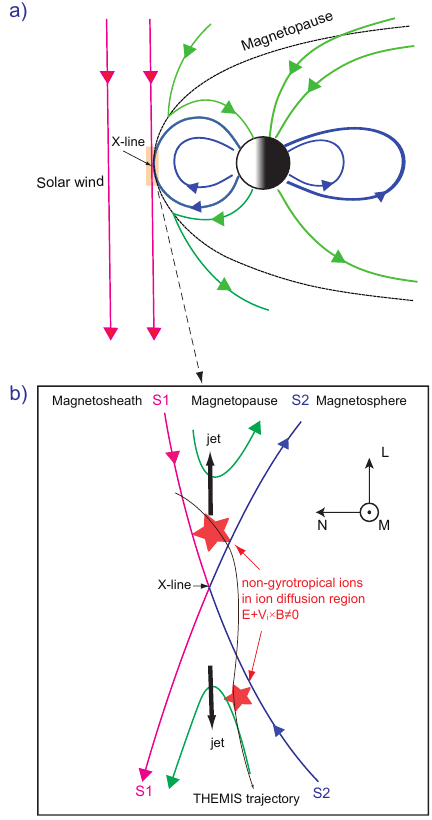
Figure 1. Schematics of magnetic reconnection in the Earth’s mag- netopause. Panel (a) : the magnetic field geometry at the dayside magnetopause reconnection viewed in the noon–midnight plane. Magnetic field lines near magnetopause reconnection can be di- vided into three classes according to their topology: (1) interplane- tary field lines (red) with no magnetic foot on the Earth; (2) “open” field lines (green) with one magnetic foot connected to the Earth and (3) “closed” field lines (blue) with both magnetic feet connected to the Earth. Two branches of separatrix surface S1 and S2 intersect along a magnetic “ X -line” directed out of the plane. Panel (b) : the expanded view of the region surrounding the X -line. A portion of the plasma outflow came across the ion diffusion region identified by a significant deviation of E from − V i × B